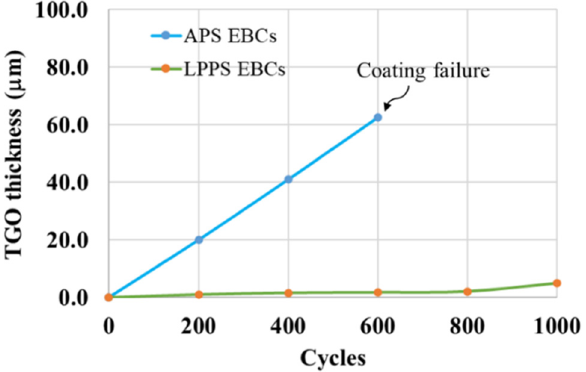
Figure 10. TGO thickness as a function of cycles for APS and LPPS EBCs at 1316 °C in 90% H 2 O- 10%